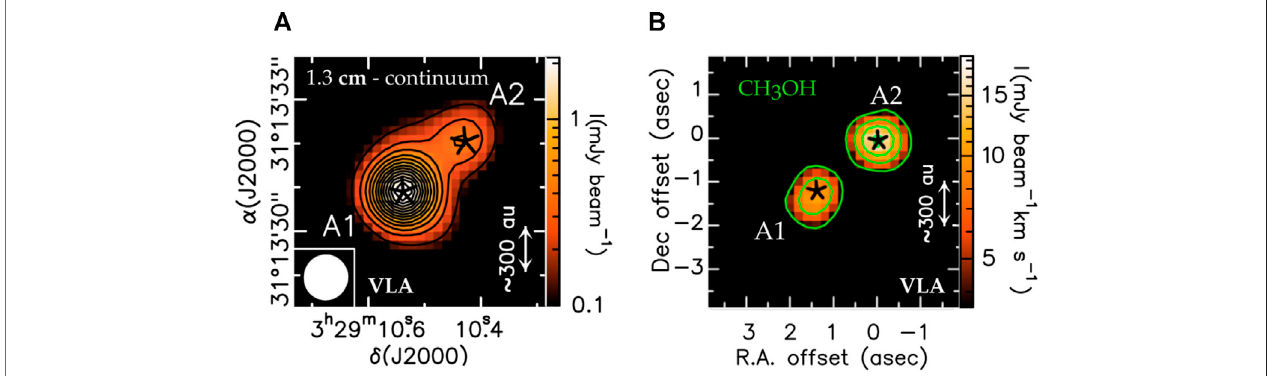
FIGURE 5 | (A) : NGC1333 IRAS 4A continuum emission map at 25 GHz as imaged using VLA (Adapted from De Simone et al. (2020)). Two protostars A1 and A2 are observed. (B) : CH 3 OH(6 2,4 – 6 1,5 ) velocity-integrated maps in the color scale, revealing for the fi rst time the hot-corino associated with A1, missed by sub-millimeter surveys due to dust opacity